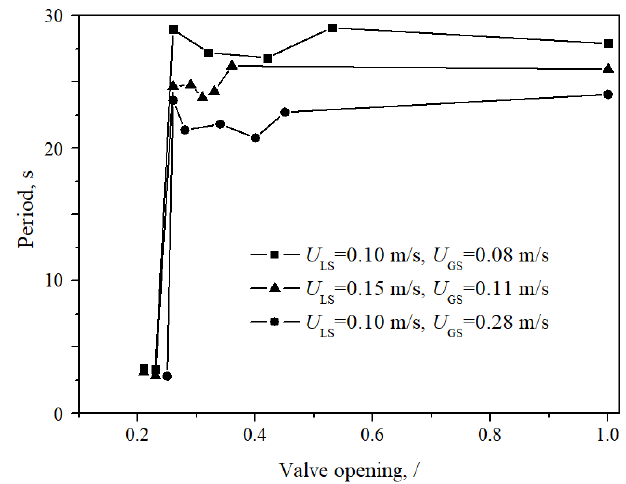
Figure 6. Cycling period against valve opening.